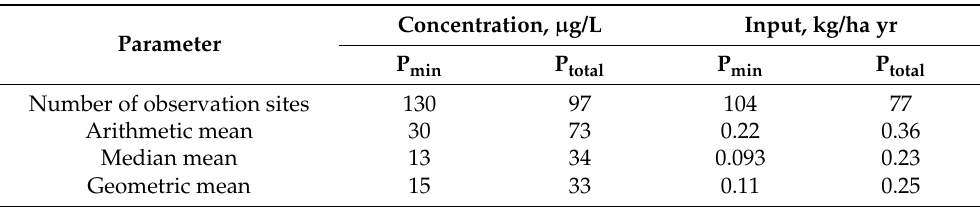
Table 2. Concentration of phosphorus in atmospheric precipitation and its input on the earth’s surface with wet precipitation [7].